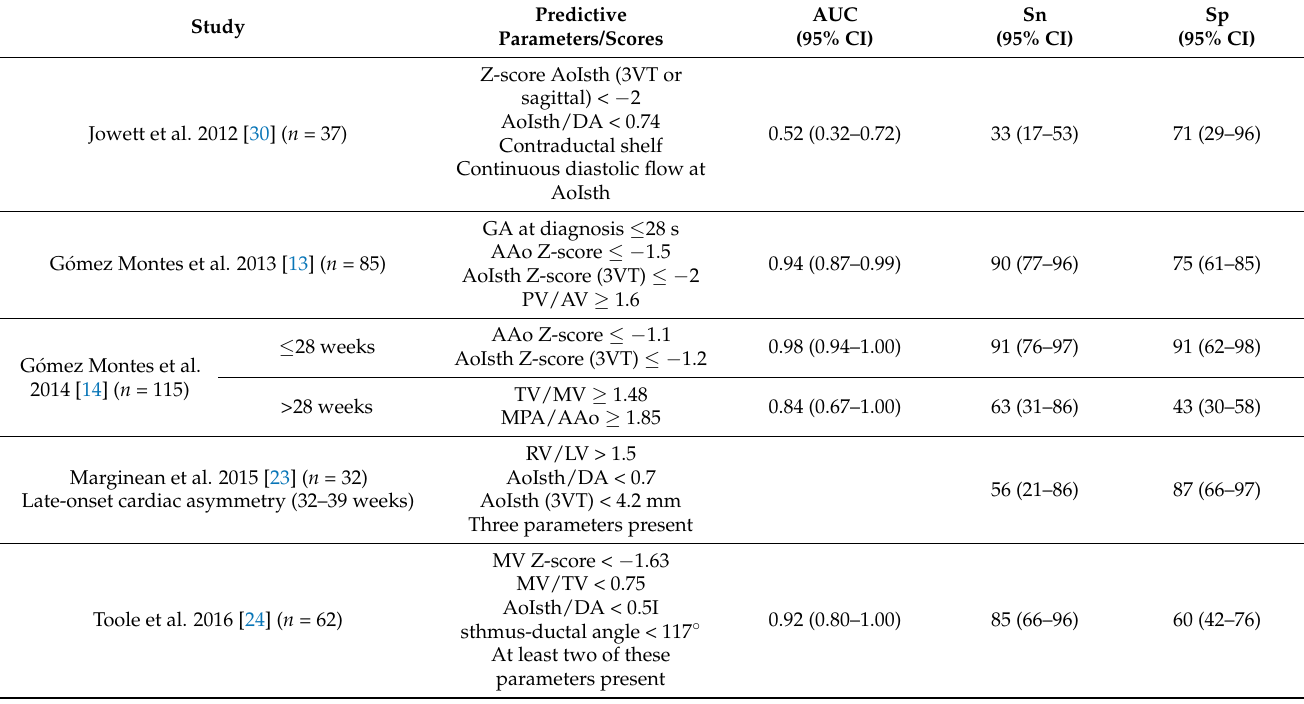
Table 4. Echocardiographic variables and multiparameter scores proposed by several groups for prenatal prediction of coarctation of the